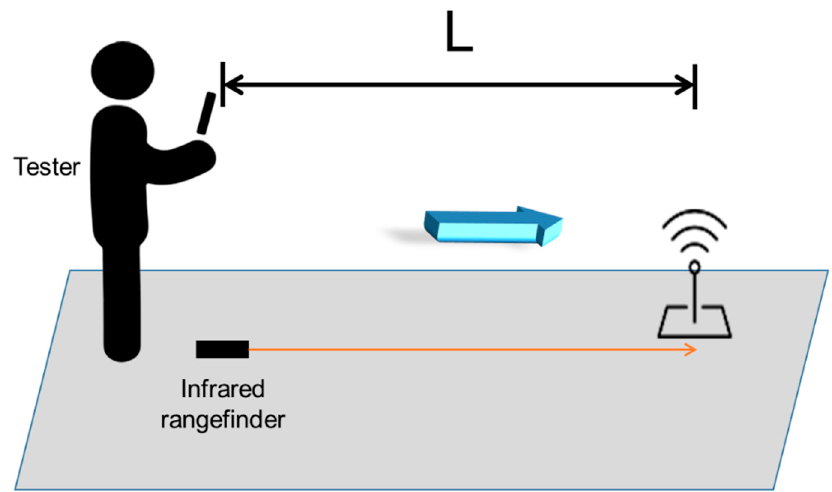
Figure 11. The experimental setup for measuring responsiveness.